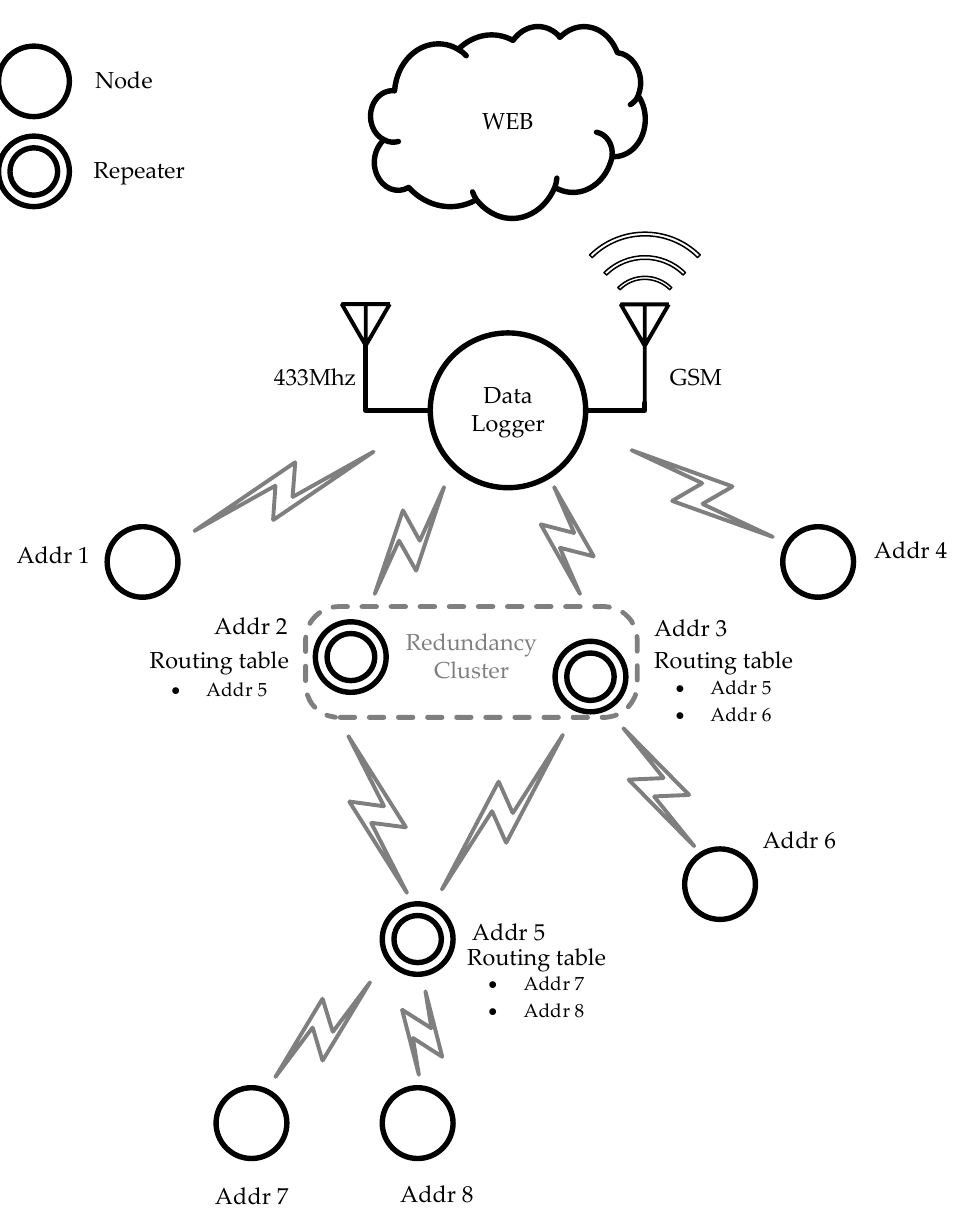
Figure 6. Network logical topology.